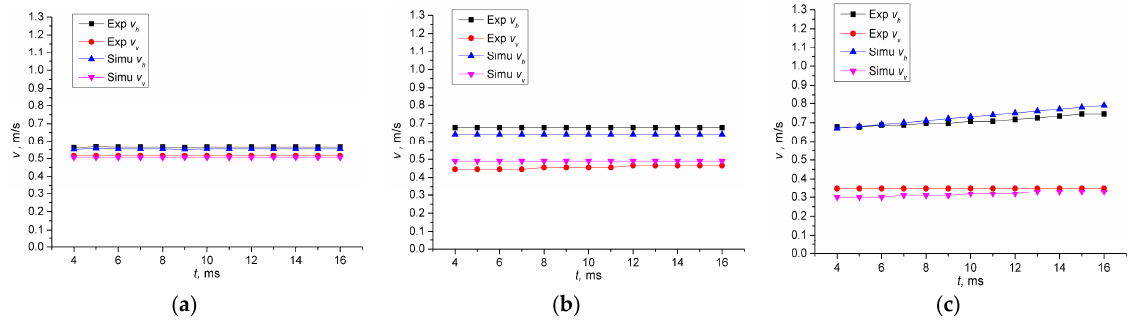
Figure 6. Flame propagation speed in the two directions in simulation and experiment: ( a ) 0 kV; ( b ) − 2.5 kV; and ( c ) − 5 kV.